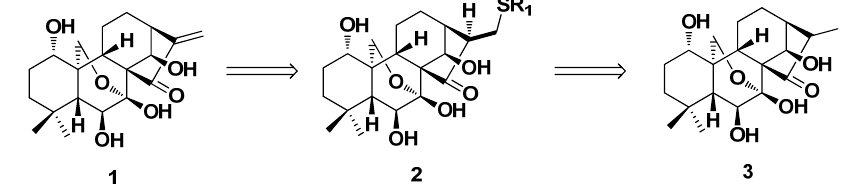
Figure 2. The biomimetic products ( 2 ) and dihydro-derivative ( 3 ) of oridonin.